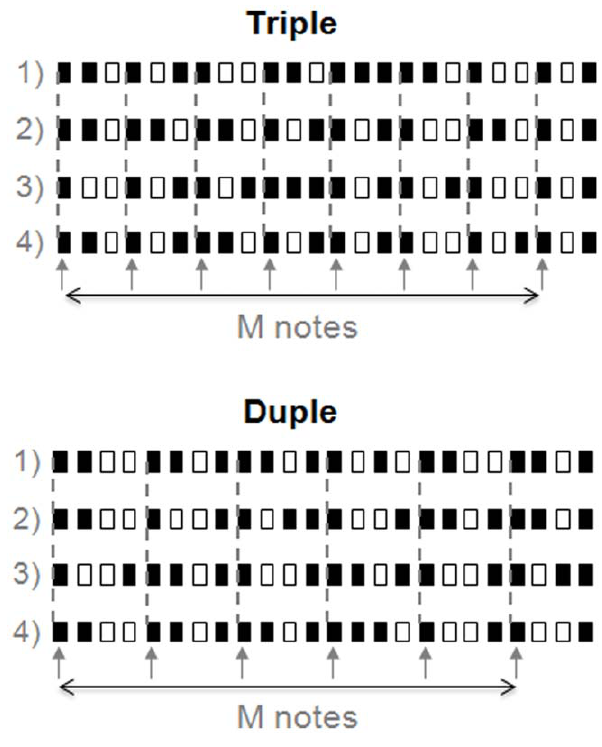
Figure 1. Examples of triple and duple sequences. Stimuli are event sequences with different rhythms composed of 24 temporal units that were 500 ms in duration, nine of which were silent units (open bars) and 15 of which were note units (dark bars). Each open bar represents a 500 ms silence. Each dark bar represents a note (pure tone/sinusoidal vibration) with a duration of 350 ms followed by 150 ms of silence. Triple sequences consisted of 8 notes (every third unit) in metrically important positions (M notes) and 7 notes in metrically unimportant positions (N notes). Duple sequences consisted of 6 M notes (every fourth unit) and 9 N notes. Arrows and dashed lines indicate M notes in the sequences.